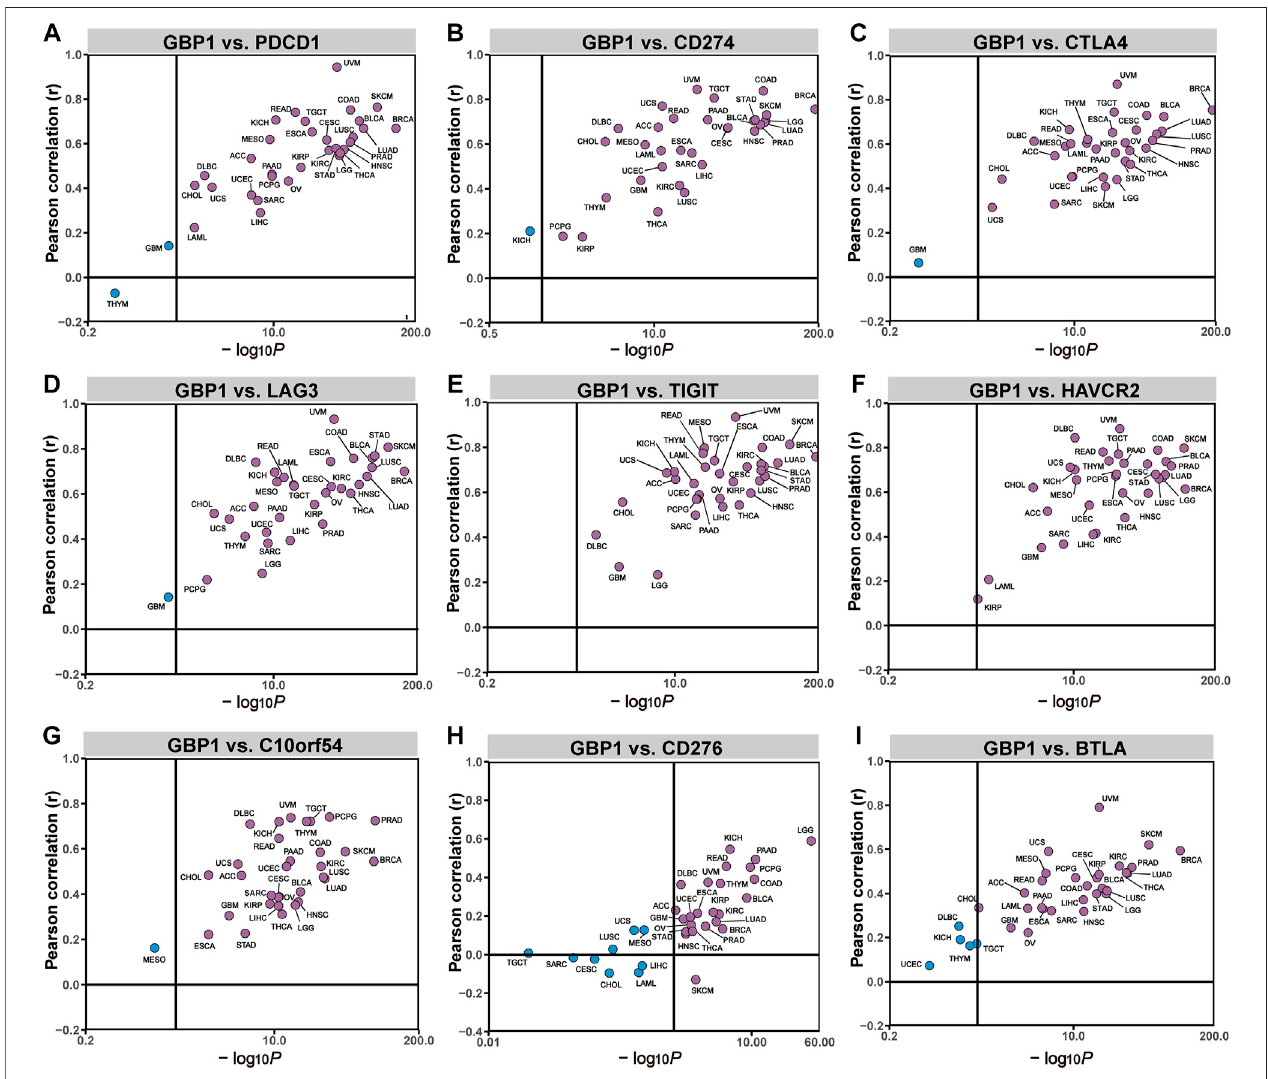
FIGURE 5 | correlation between GBP1 expression and the expression levels of immune checkpoints. The correlation of GBP1 expression with PDCD1 (A) , CD274 (B) , CTLA4 (C) , LAG3 (D) , TIGIT (E) , HAVCR2 (F) , C10orf54 (G) , CD276 (H) , and BTLA (I) across 33 cancer types.